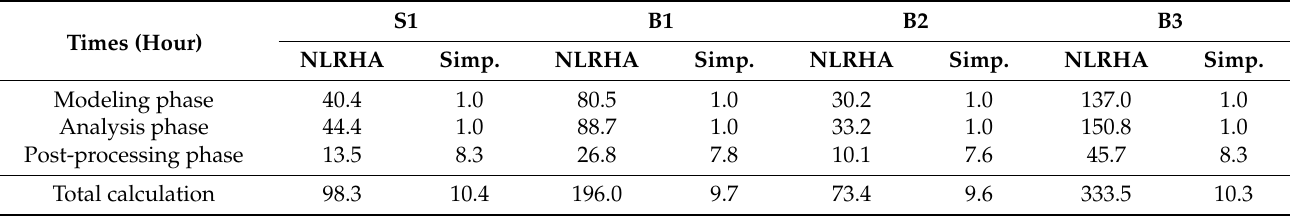
Table 5. Total calculation time of the four case study